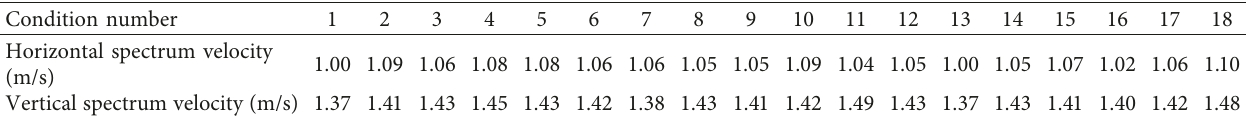
Table 6: Comparison of the structure’s average response on the starboard side.